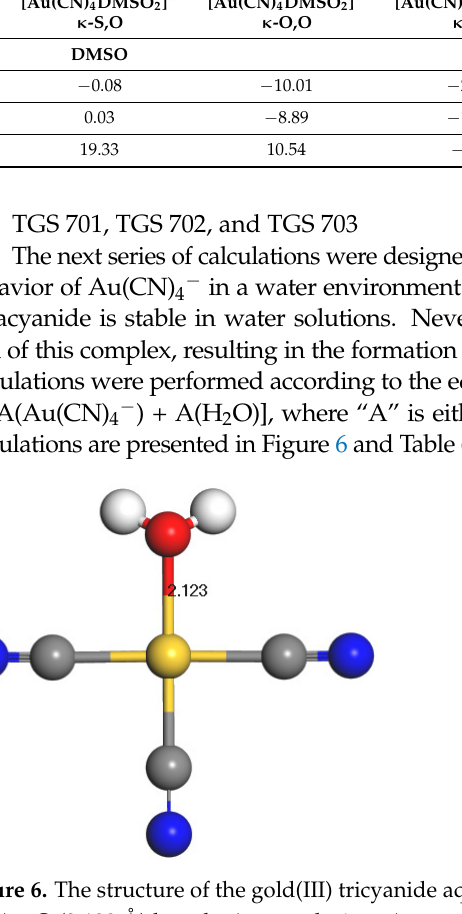
Table 5. Energy (E); energy corrected by the zero-point vibrational energy (E + ZPVE); Gibbs free energy ( ∆ G) of the complex formation of gold(III) tetracyanide dimethyl sulfide (1:2) complex. In vacuo—results obtained without solvation. DMSO—results obtained using PCM implicit solvation model. All values are in kcal/mol.